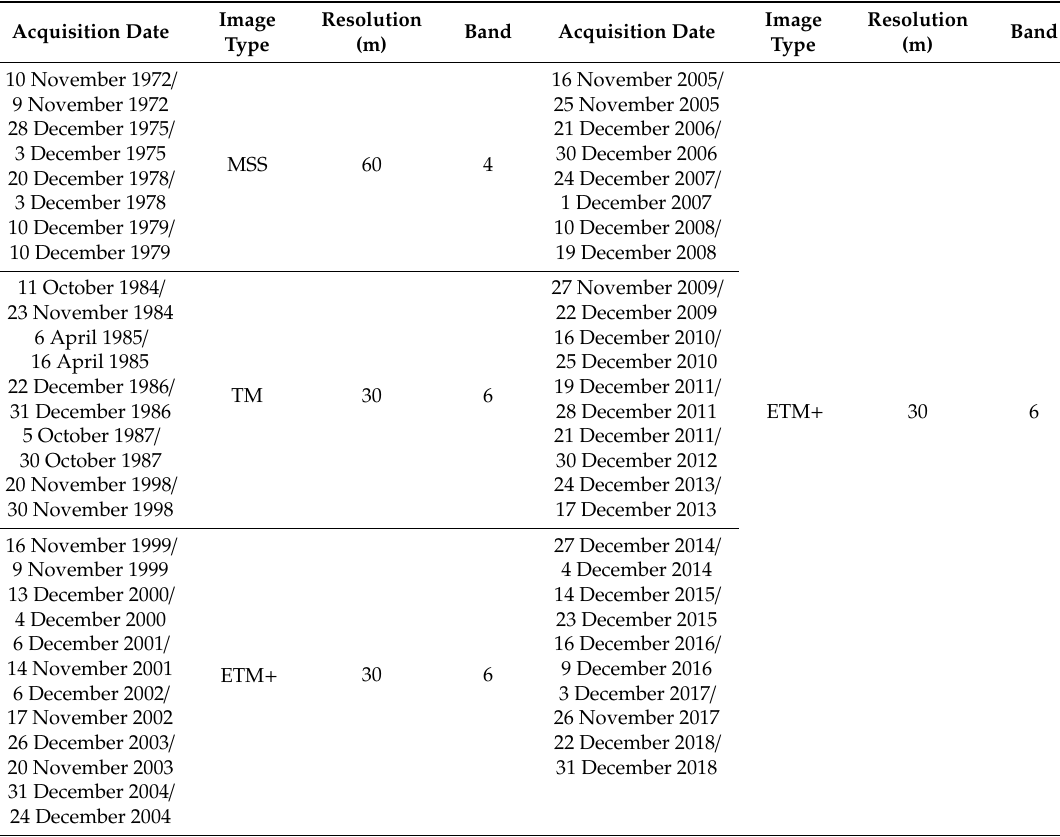
Table 1. List of Landsat images used in this